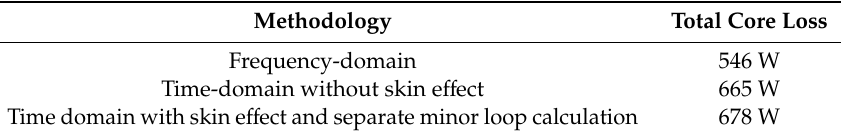
Table 3. Motor core loses calculated using di ff erent